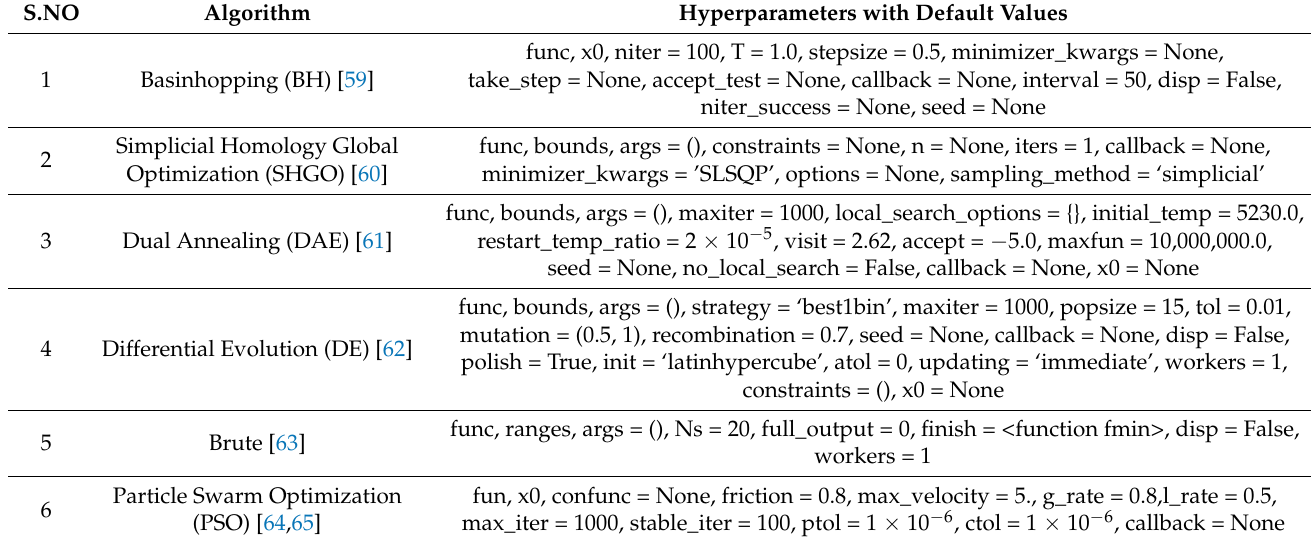
Table 5. Hyperparameters for the five global optimization algorithms from the SciPy library addi- tionally with